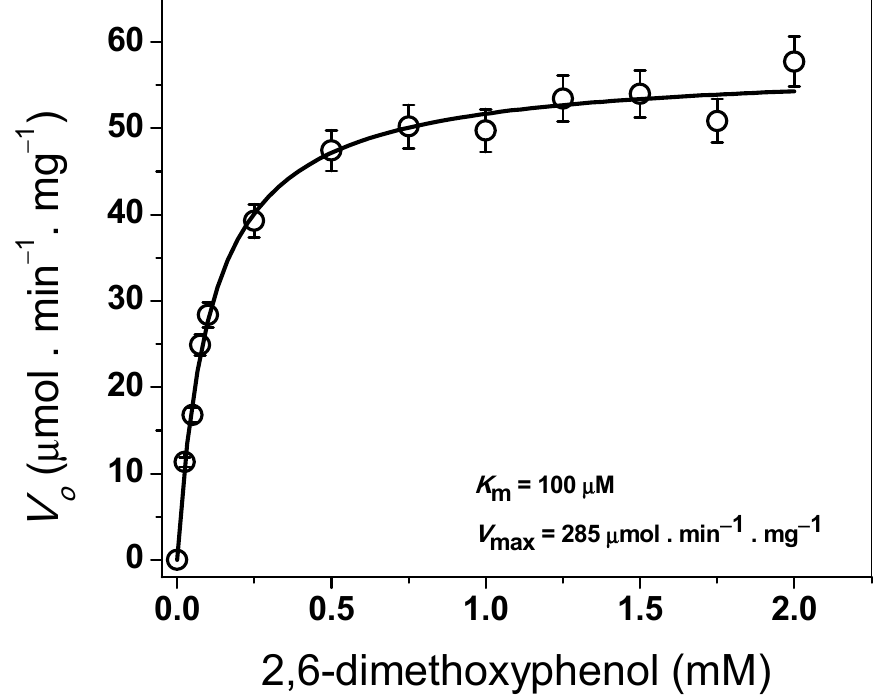
Figure 6. Determination of steady-state kinetic parameters of extracellular laccase purified from A . pediades cultures. Initial velocity data for the 2,6-DMP substrate were obtained for varying substrate concentrations, indicated in the abscissa axis, and fitted to the Michaelis–Menten equation by nonlinear regression calculations.